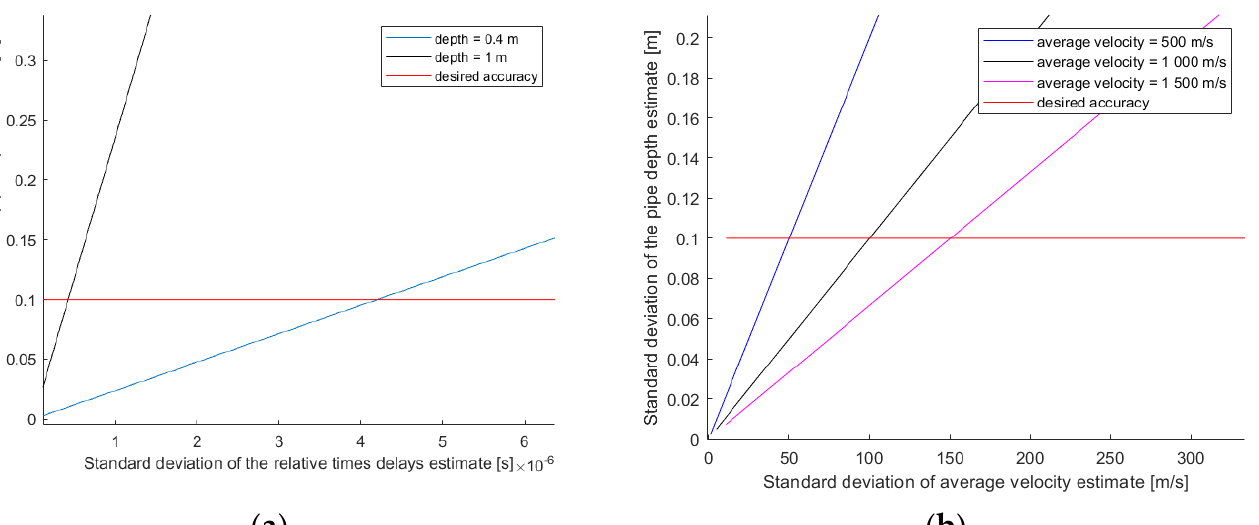
Figure 4. Depth error boundary as a function of the error of the other variables: ( a ) depth error as a function of the error in the relative delay times; ( b ) depth error as a function of the error in the propagation velocity.